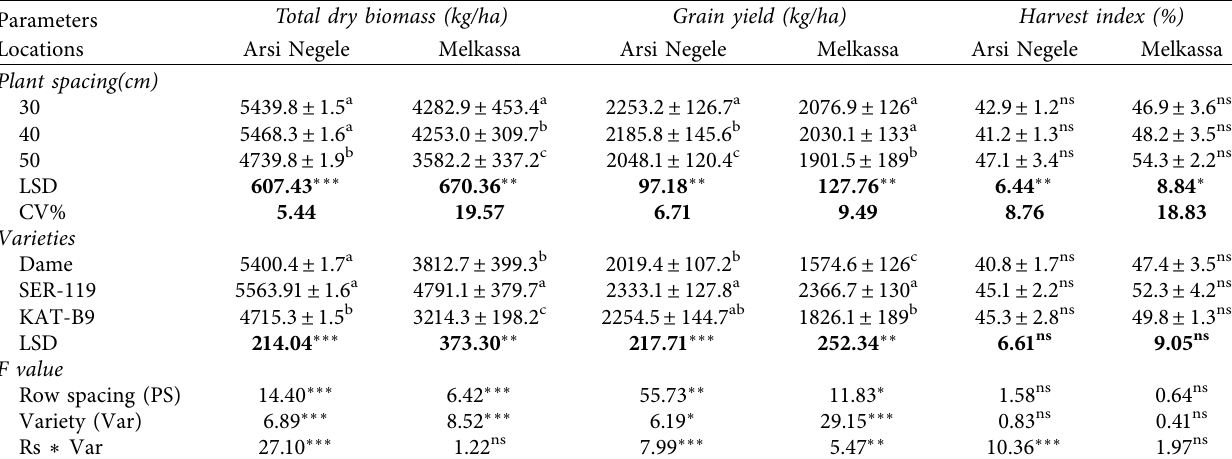
Table 5: Efect of interrow spacing on total dry biomass, grain yield, and harvest index of common bean varieties at the Arsi Negele and Melkasa sites.